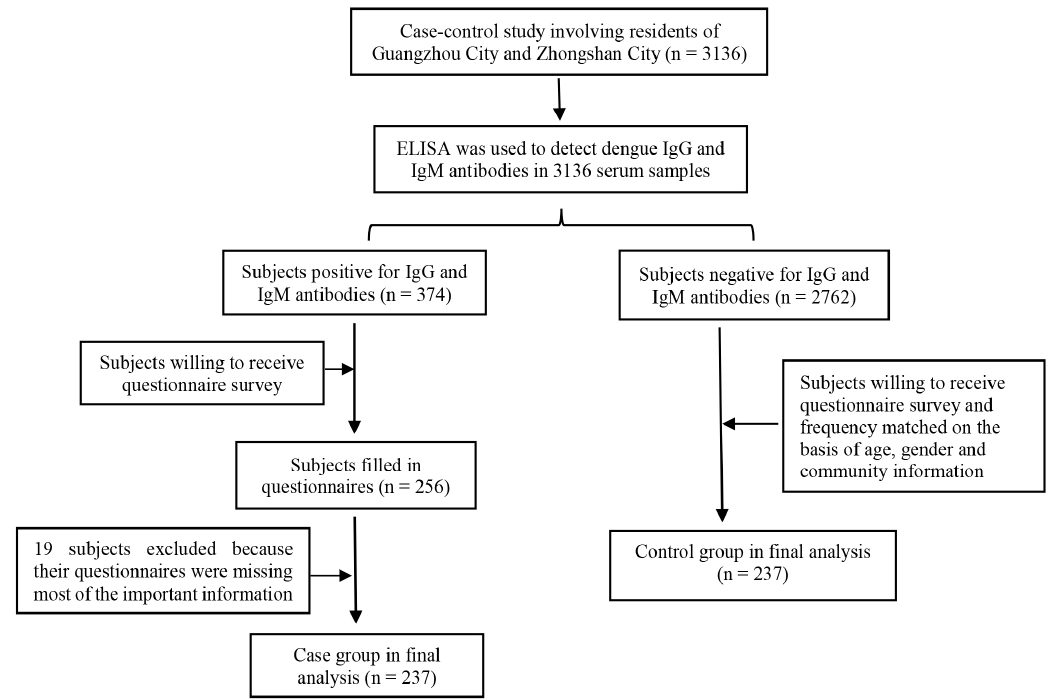
Figure 1. Consort diagram of cases and controls used in the study.